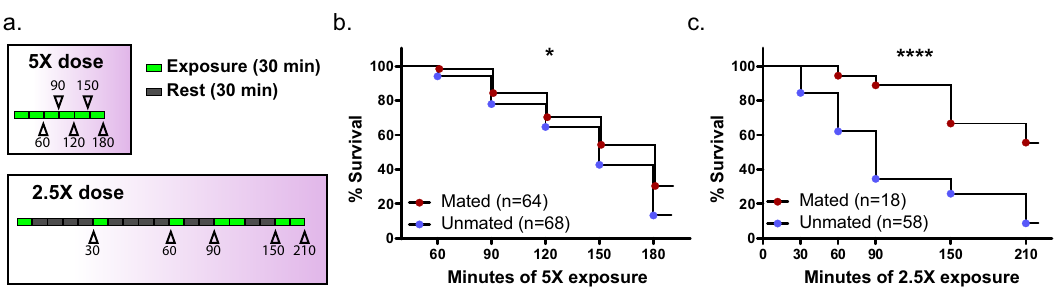
Fig. 2 Successful males have higher permethrin resistance. Mated and control unmated males were captured from natural swarms as in Fig. 1a. a These males were exposed to either a continuous 5× dose of permethrin (upper panel) or a series of 30 or 60 min 2.5× permethrin exposures (lower panel) and monitored for knockdown after each exposure. Schematics represent 30-min time intervals as either exposure periods (green) or rest periods (gray). Arrowheads denote time points for survival monitoring, labeled according to the cumulative minutes of permethrin exposure. Mated males survived longer on average to these permethrin exposures compared to unmated males for both the b 5× ( p = 0.036) and c 2.5× ( p < 0.0001) doses (log-rank tests). n represents total number of mosquitoes.